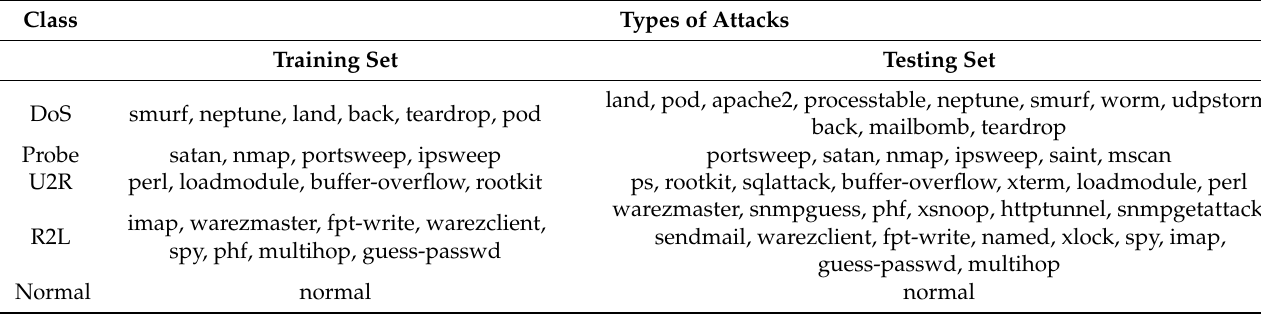
Table 3. Categories of the various attack